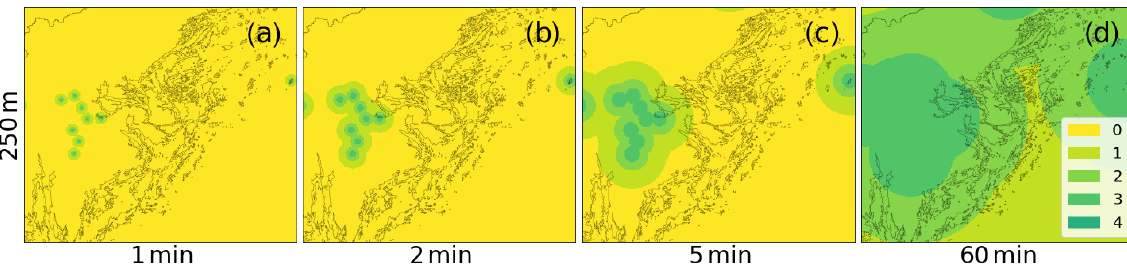
Figure 5. Map of the attainable quality at 1, 2, 5, 60min and 250m resolution summer precipitation regime (DOY 206) using rain gauges and a variogram for southern Sweden. The colors represent the quality levels equal to Fig. 1a and